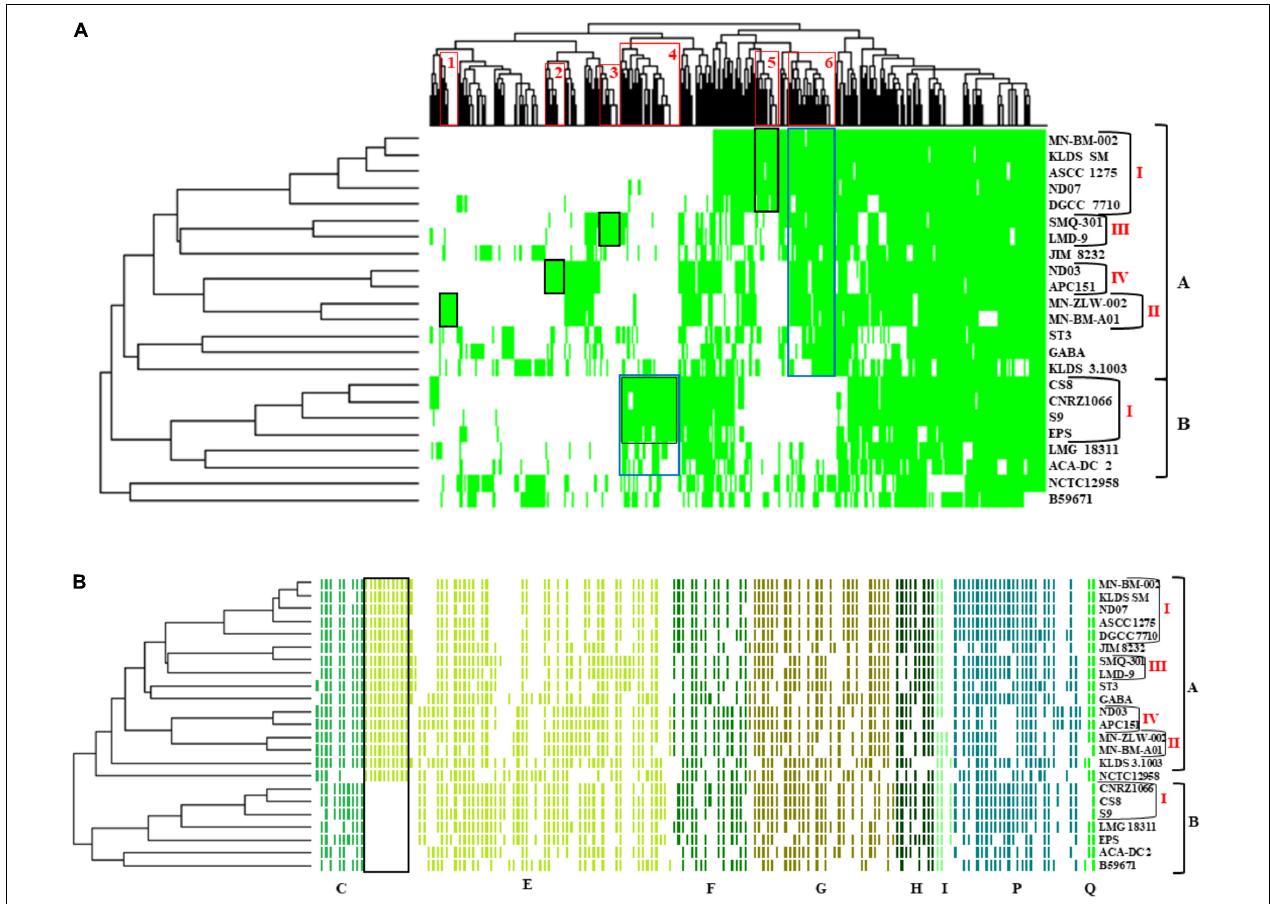
FIGURE 5 | Presence/absence heat map and two-dimensional hierarchical clustering of the 23 S. thermophilus strains accessory genome (A) . Colored areas represent the presence of genes in the respective S. thermophilus strains, while white areas indicate the absence of genes. Accessory genes clustered according to their presence in specific subgroups or clusters of strains (gene clusters 1 to 6) are highlighted with red frames on the x axis. The presence of a specific gene cluster in cluster A or B as well as specific subgroups of strains is highlighted with blue or black frames, respectively. Presence/absence heat map and hierarchical clustering of S. thermophilus strains based on accessory genes with clusters of orthologous groups (COG) assignment involved in metabolism (categories C, E, F, G, H, I, P, and Q) (B) . Colored areas represent the presence of genes in the respective S. thermophilus strains, while white areas indicate the absence of genes. Genes implicated in the biosynthesis of histidine are highlighted with a black frame. Of note, panel (B) is a composite figure of an excel generated table manually colored, while clustering was exported from RStudio. This was necessary to achieve clustering of genes grouped based on COG